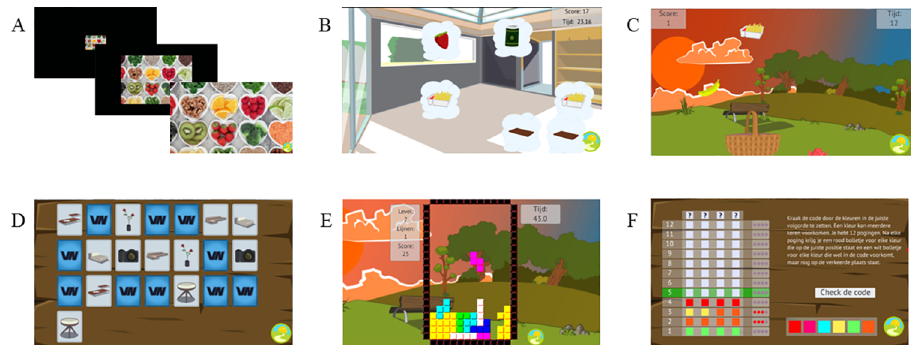
Fig 1. Screenshots of all games. (A) Serious game in which participants were instructed to approach healthy items and avoid unhealthy items by pressing the corresponding arrows on the keyboard; (B) Serious game in which participants were instructed to click away the unhealthy items; (C) Serious game in which participants were instructed to collect the healthy items in a basket; (D) Non-health-related game in which participants were instructed to find and match similar pictures; (E) Non-health-related game in which participants were instructed to complete horizontal lines with various shaped blocks that fell down; (F) Non-health-related game in which participants were instructed to guess a color code by identifying the color